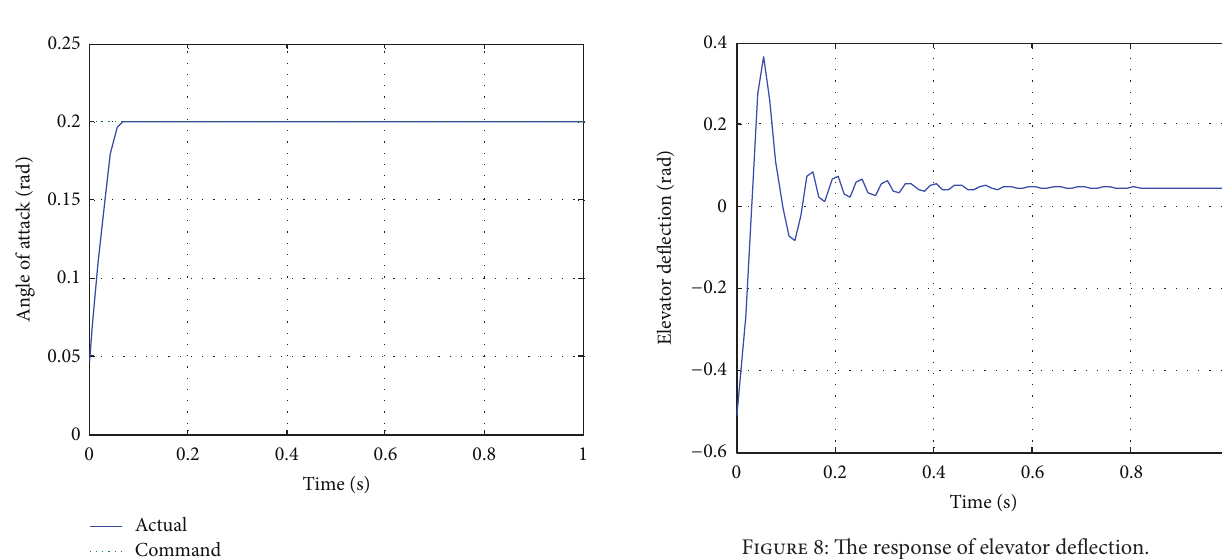
Figure 8: The response of elevator